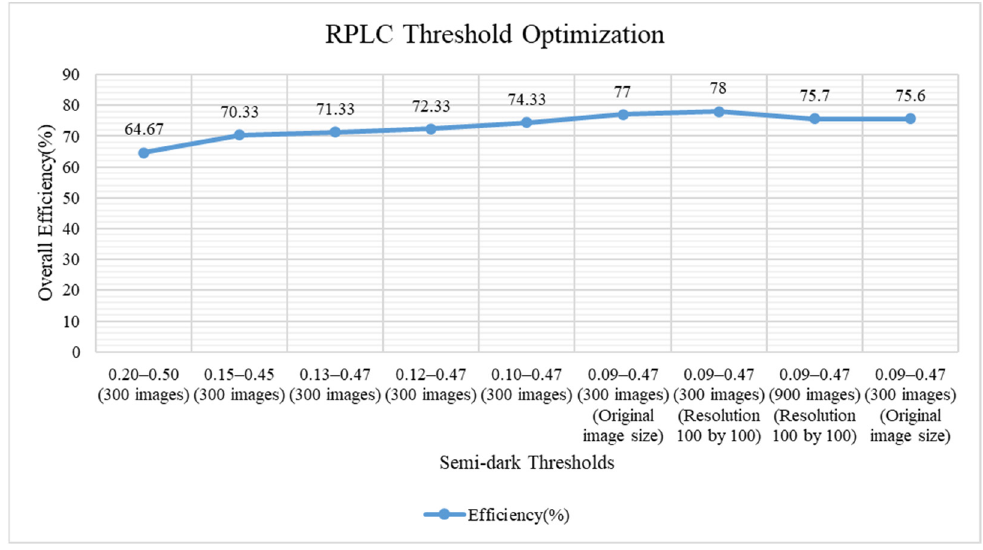
Figure 5. RPLC Threshold rejection & identification.